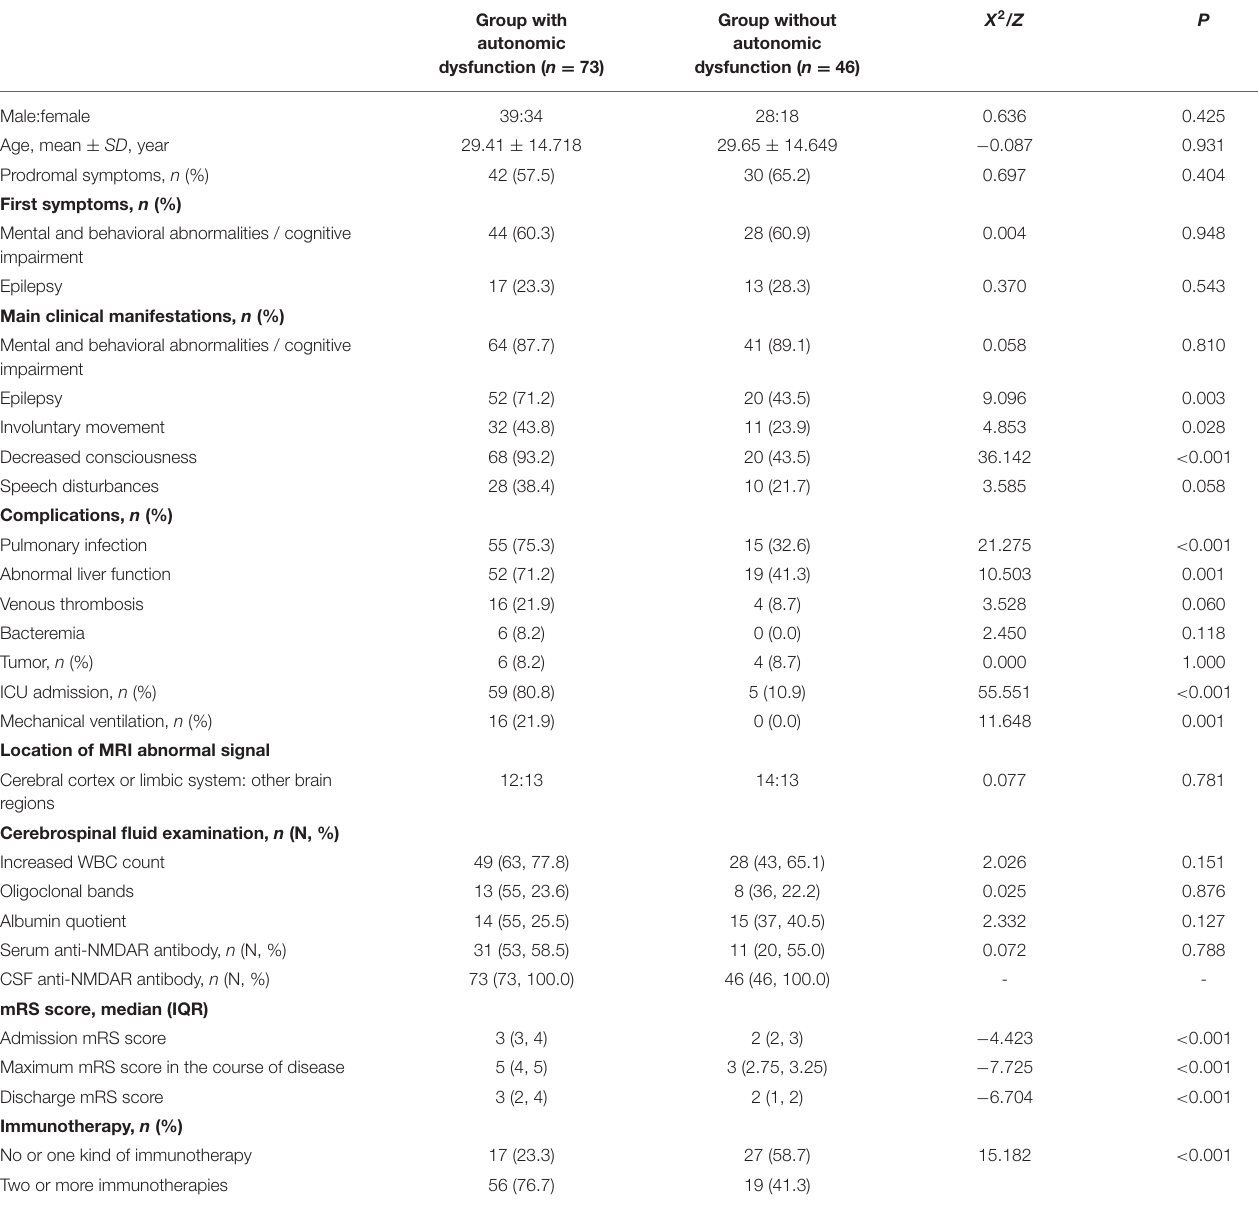
TABLE 2 | Comparison between two groups of patients with or without autonomic dysfunction.